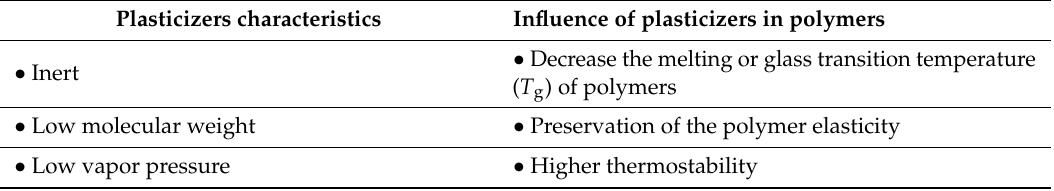
Table 4. General characteristics of plasticizers and their influence in polymers